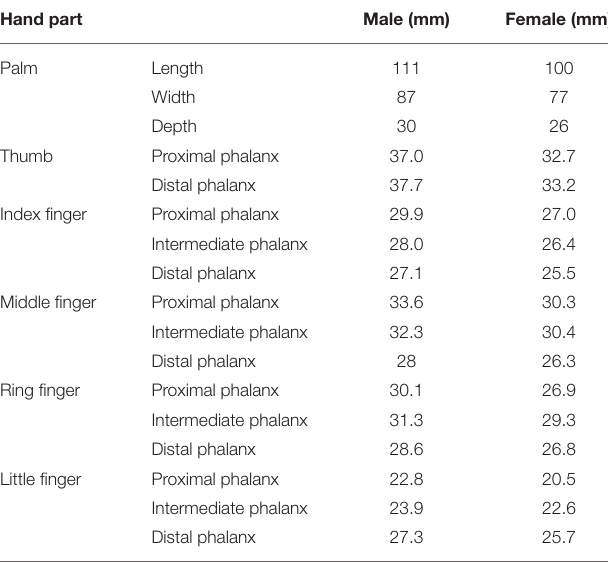
TABLE 2 | Dimensions of the KIT prosthetic hands.